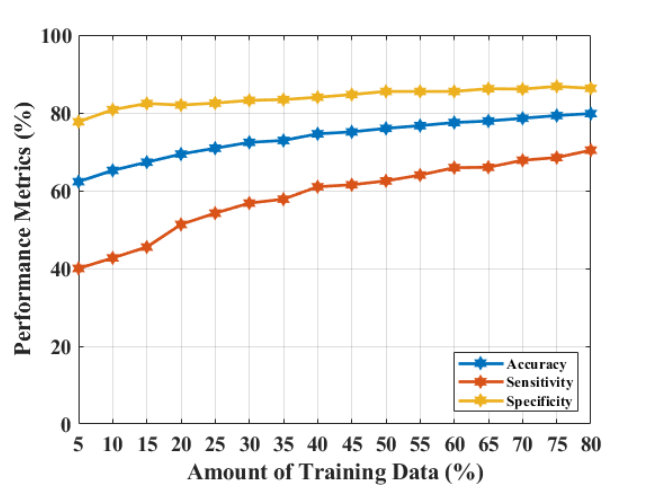
Figure 3. NF and WF signal prediction results (accuracy, sensitivity, and specificity) obtained using real-parts of the MammoWave’s frequency response and SVM RBF , applying different amounts of training data.